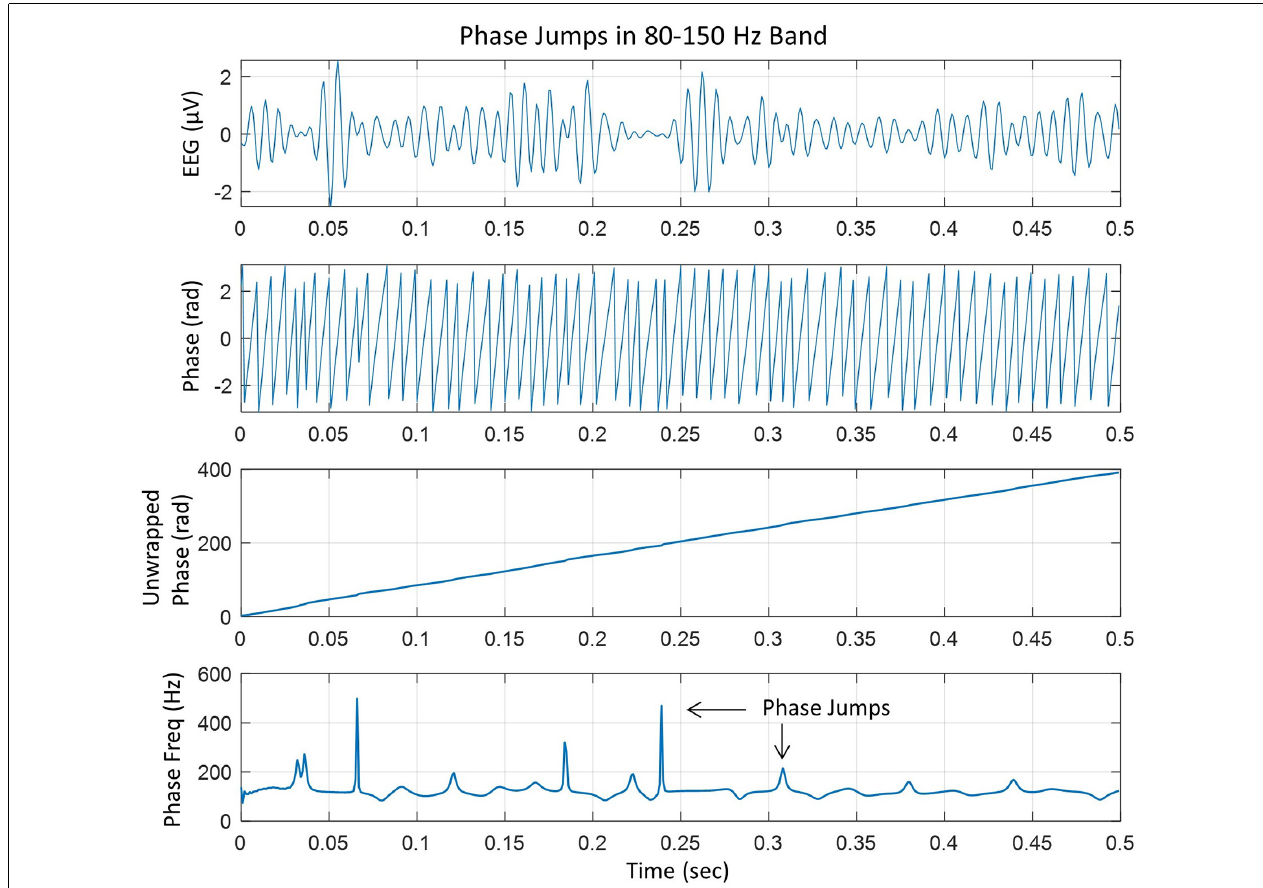
FIGURE 1 | (Top) EEG trace filtered in the 80–150 Hz ripple band, (second plot from the top) phase in radians extracted after taking Hilbert transform of the EEG trace, (third plot from the top) unwrapped phase in radians which is almost linear with slight variations, and (bottom plot), taking the derivative of the unwrapped phase and dividing by 2 π to get the instantaneous phase-frequency in cycles/s or Hz. The peaks are phase jumps that appear whenever there is a slight perturbation, particularly near the zero crossing line in the EEG